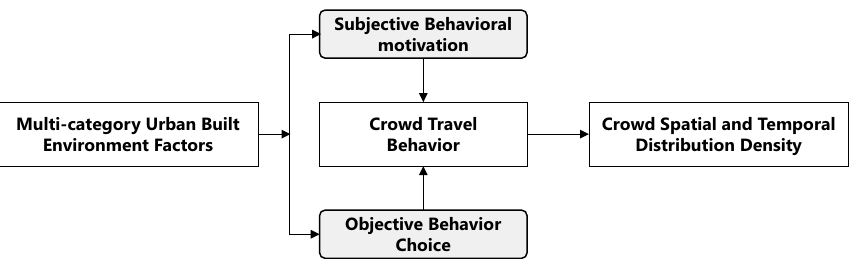
Figure 1. Brief concept model of interrelationship between behaviour and environment. Source Author